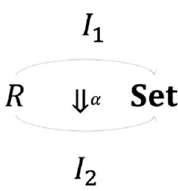
Figure 7. Isomorphism between two